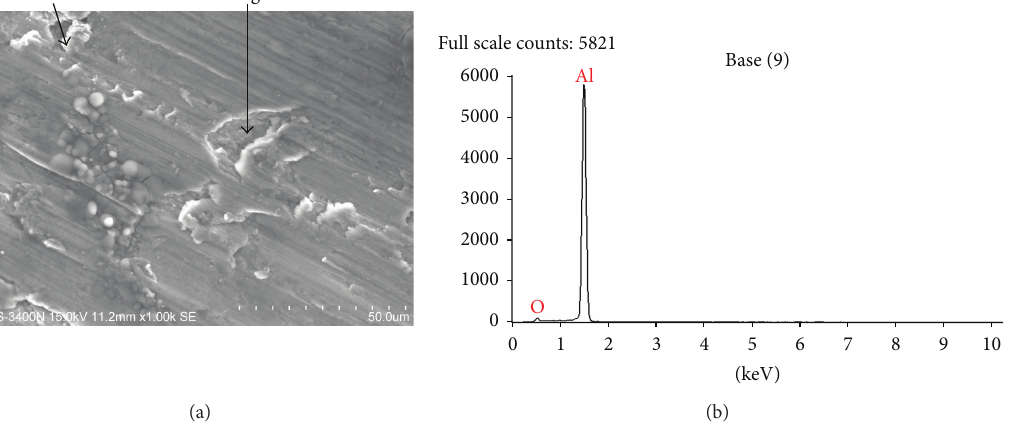
Figure 12: (a) SEM and (b) EDX analysis of worn surface of Al + 0% graphite; load-10 N. Stable oxide layer